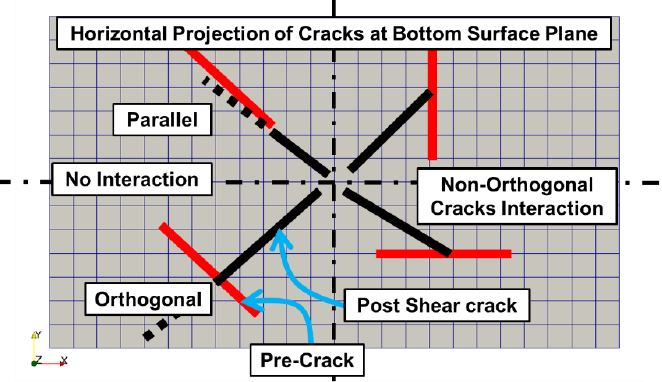
Figure 16. Horizontal projection of pre- and post-shear cracks at bottom surface of RC deck.